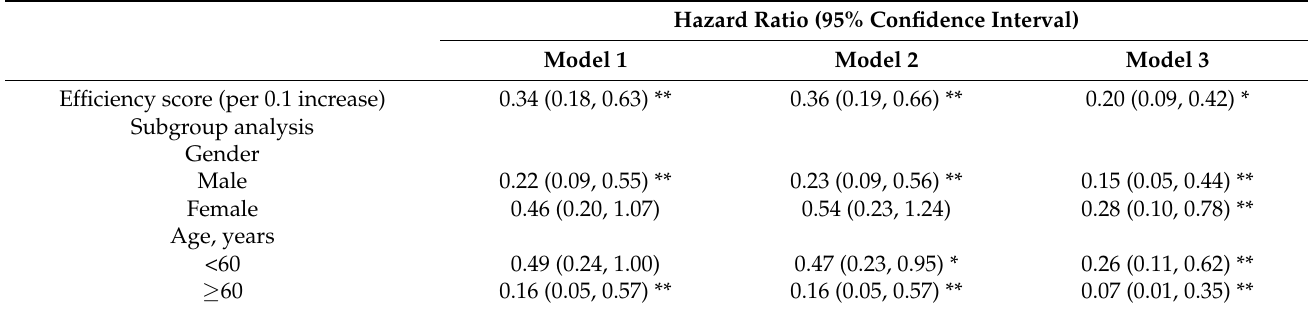
Table 2. Association between the efficiency score and risk of incident hypertension.